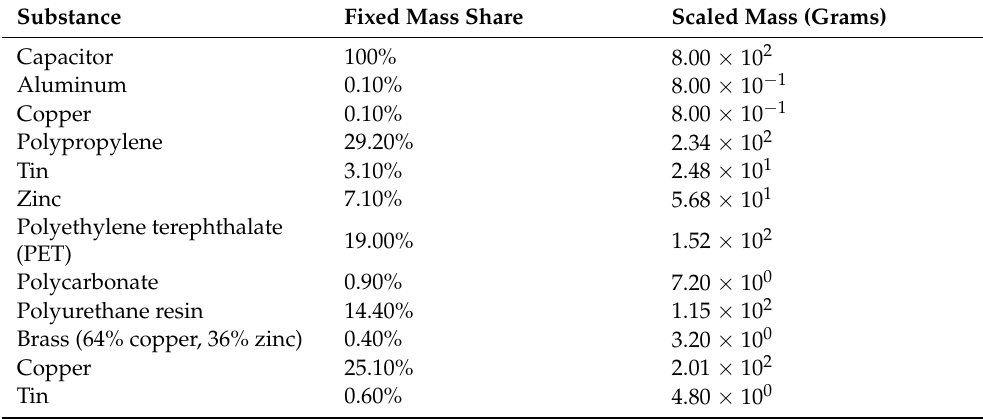
Table A2. DC-link